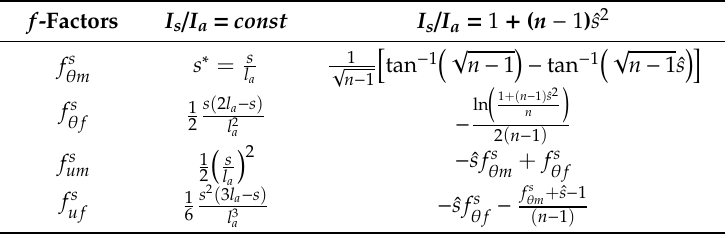
Table 2. f -factors for each support structure case.